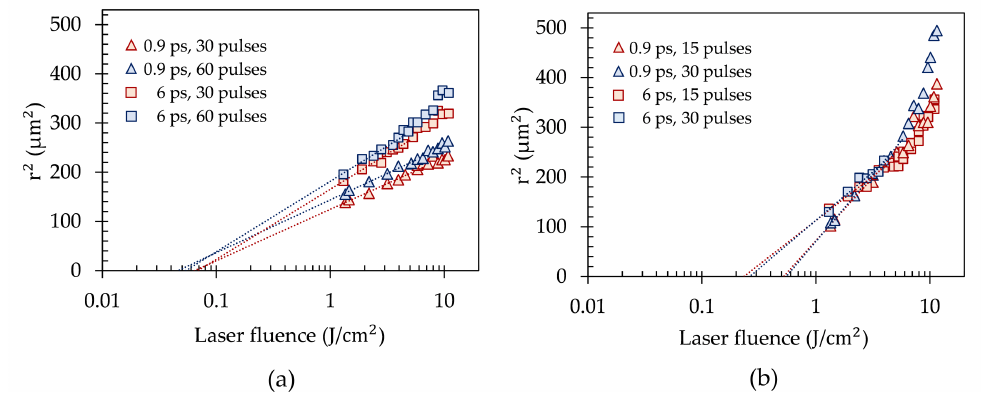
Figure 4. Ablation thresholds for ( a ) copper and ( b ) FR-4 using laser fluences of F = 1.3–11.5 J/cm 2 , laser pulse durations of τ = 0.9 and 6 ps, and a number of pulses between 15 and